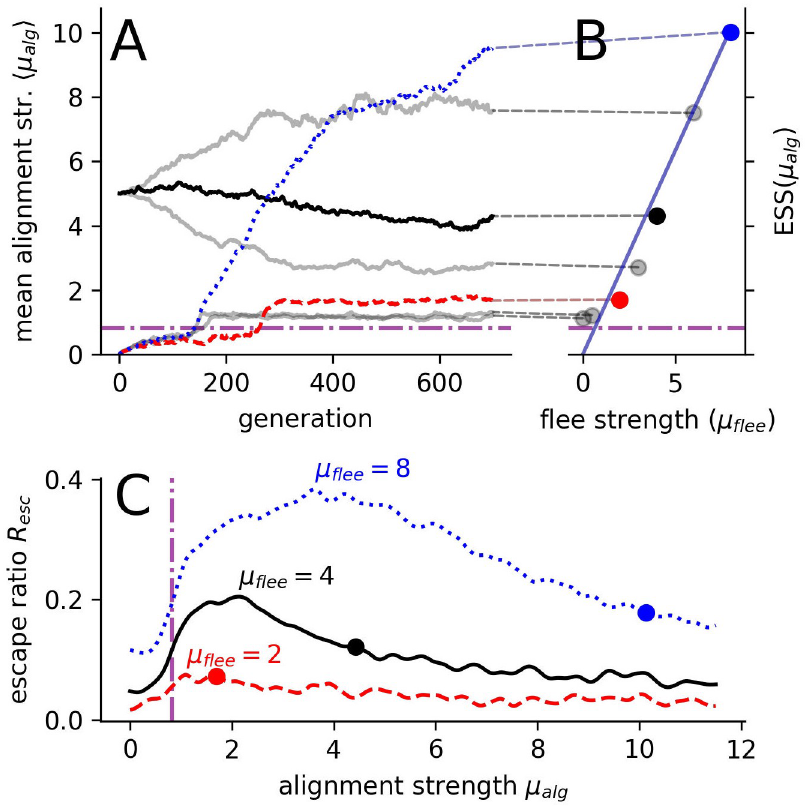
Fig 4. Evolution for different flee strengths μ . ( A ) Sample evolutionary trajectories of the mean alignment strength flee μ alg over 700 generations. ( B ) shows the dependence of evolutionary stable strategies (ESS) on the flee strength μ flee . Solid diagonal line shows the theoretically predicted linear dependence of the ESS on μ assuming balancing of social flee and private information (see SI Sec. VI). Dashed lines ( A , B ) connect the example individual evolutionary runs ( A ) to the corresponding ESSs ( B ) obtained as an average over multiple, longer evolutionary simulations. ( C ) Evolutionary stable states (circles) with respect to the group response, measured via the escape ratio R esc , for three selected flee- strengths indicated with dashed, solid and dotted lines for μ = [2, 4, 8] respectively. In all panels: the dash-dotted flee magenta line marks the order-disorder transition and the different lines/points (red, black and blue) represent results for different flee strengths μ flee = [2, 4, 8], respectively.